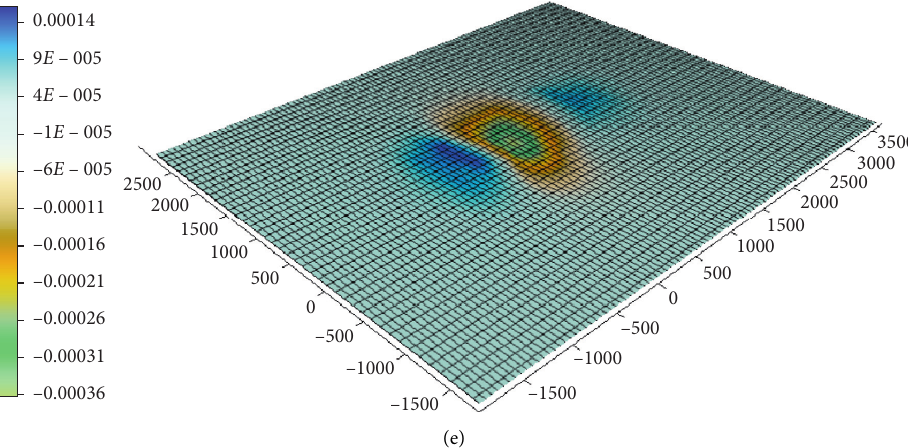
Figure 12: Final surface movement and deformation. (a) Cloud chart of surface subsidence. (b) Cloud image of surface horizontal movement. (c) Cloud chart of surface tilt. (d) Surface curvature nephogram. (e) Cloud image of surface horizontal